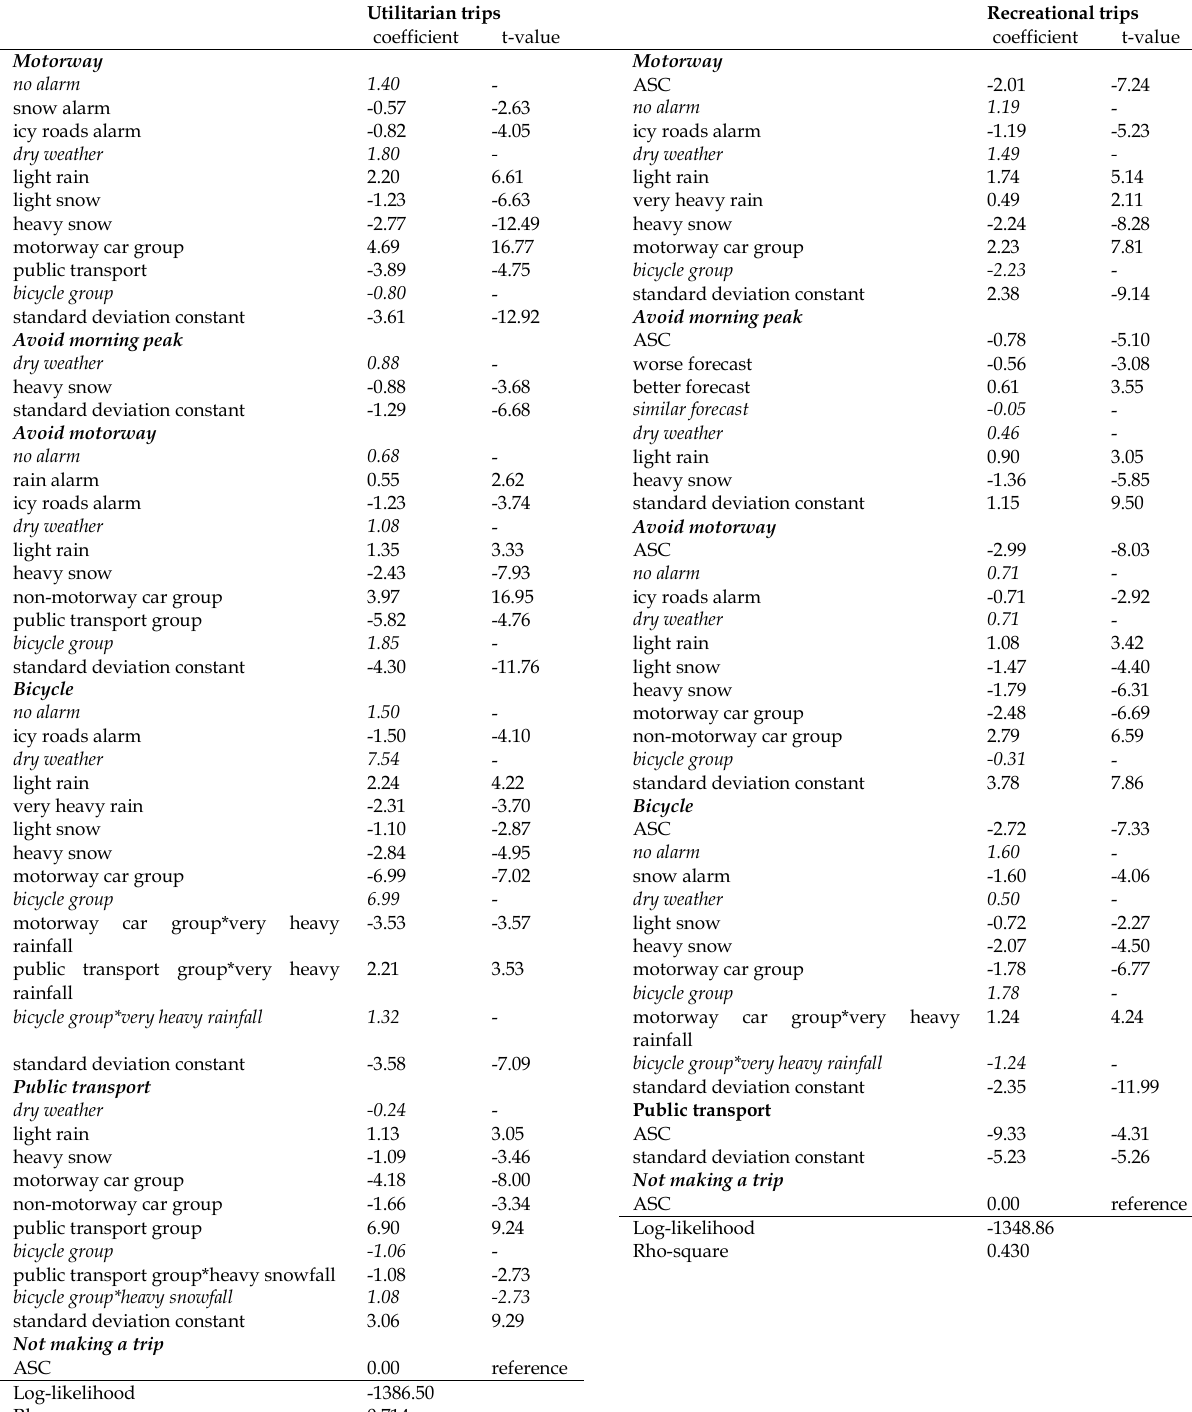
Table 3. The estimated Panel Mixed Logit utilitarian (a) and recreational (b)